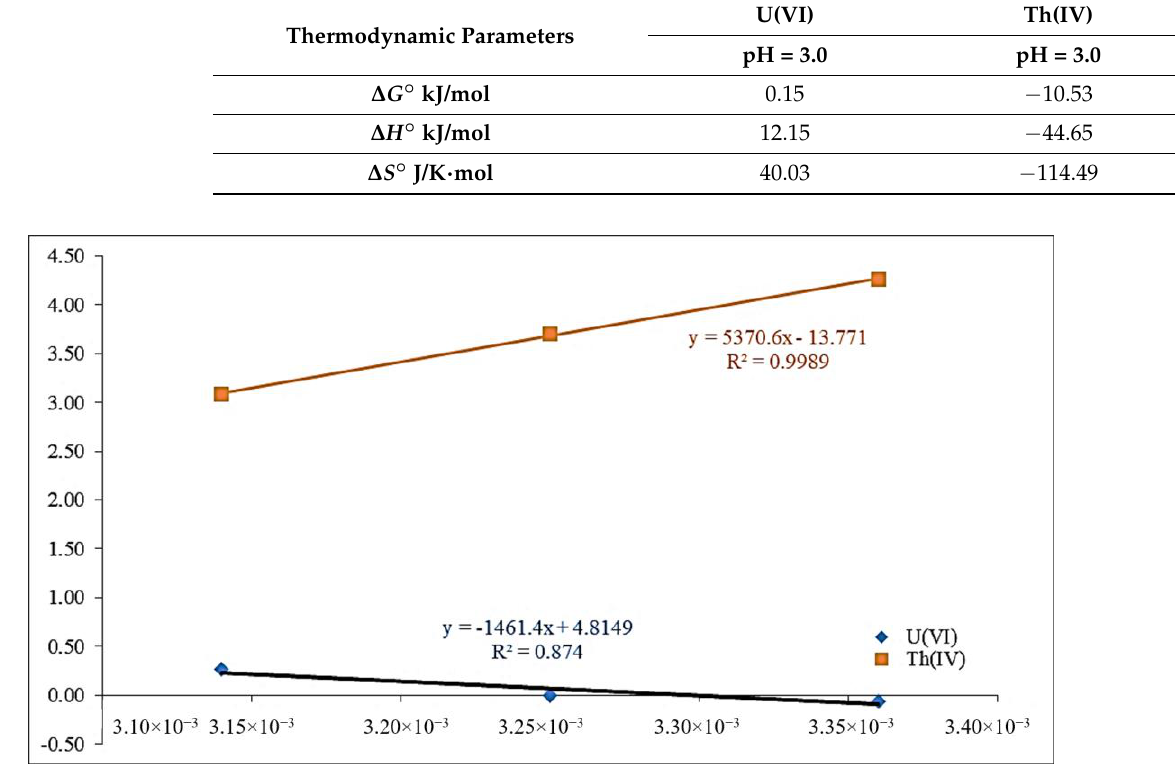
Figure 14. Plot of Ln K d Vs. 1/ T for U(VI) and Th(IV) at pH 3.0. Table 5. Δ G °, ΔH°, and ΔS° of U(VI) and Th(IV) adsorption onto CCsMFO nanocomposite at 25